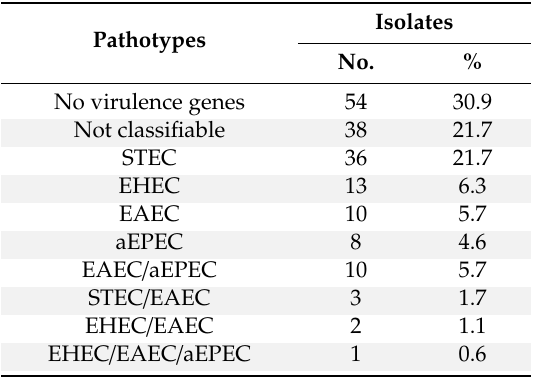
Table 2. Pathotypes detected among E. coli isolates from wild boar. STEC, Shiga toxin-producing E. coli ; EHEC, enterohemorrhagic E. coli ; EAEC, enteroaggregative E. coli ; aEPEC, atypical enteropathogenic E. coli .